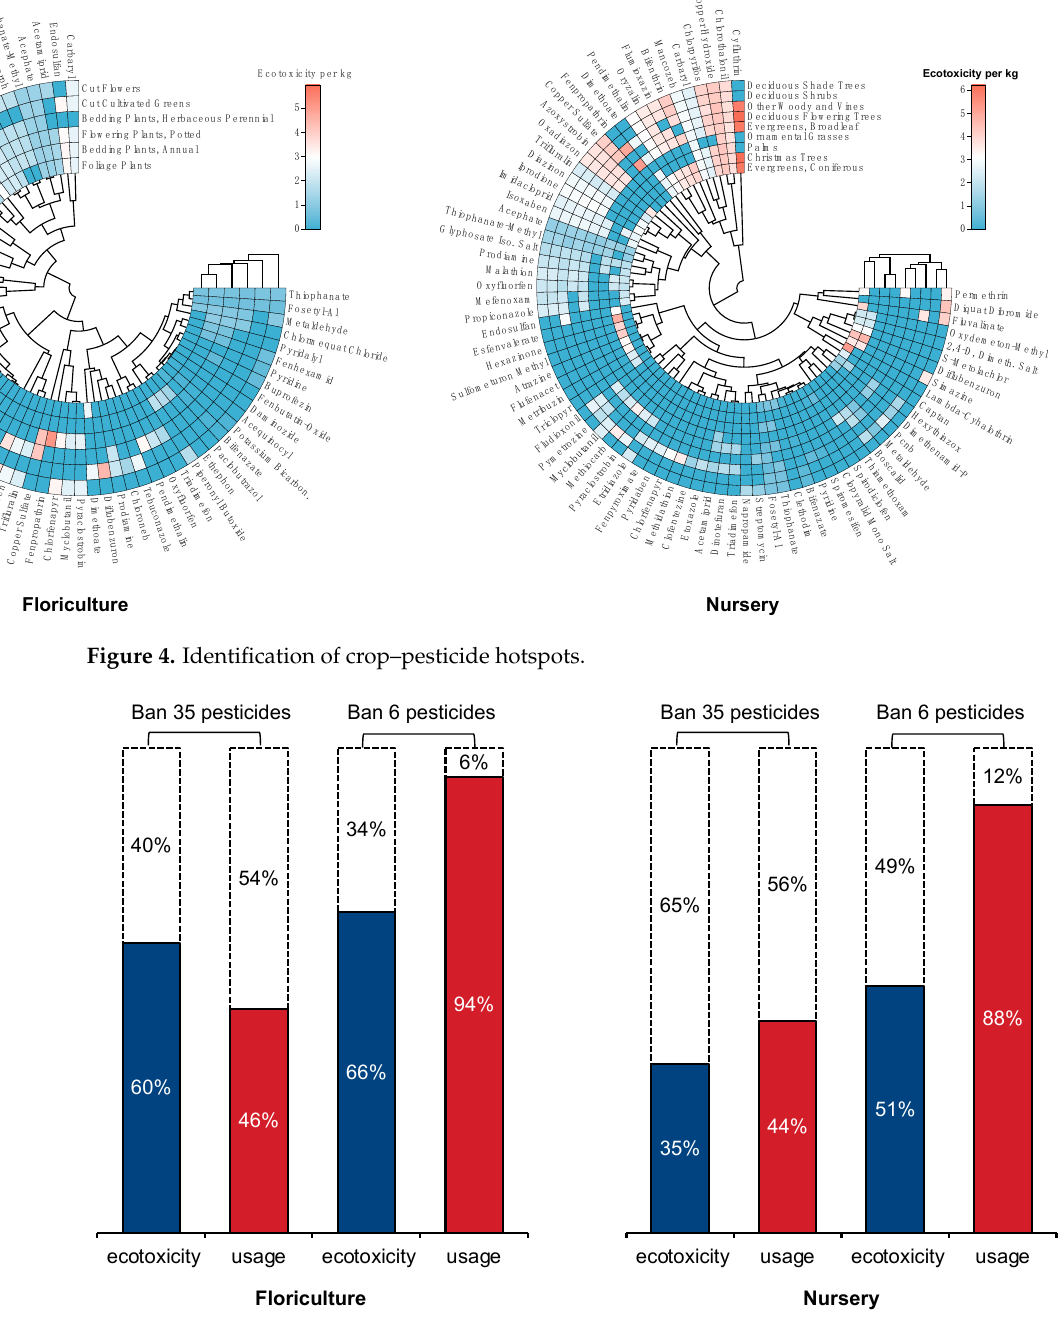
Figure 5. The potency of mitigation of pesticide ecotoxicity. The dashed boxes represent the reduction in ecotoxicity or dosage through banning hotspot pesticides, and the solid boxes represent the usage or ecotoxicity of remaining pesticides.